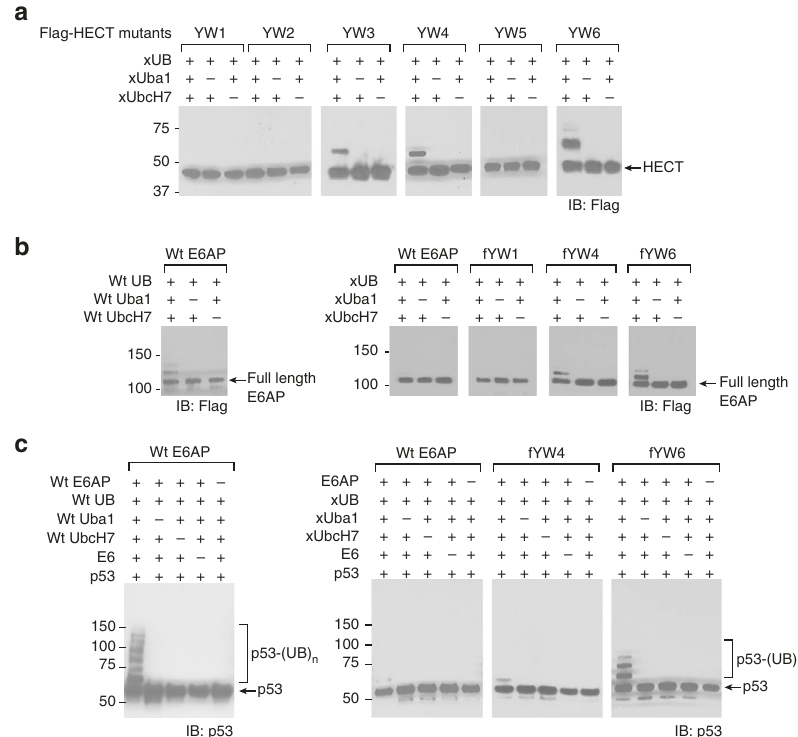
Fig. 3 Activity in xUB transfer by the E6AP mutants identi fi ed from yeast cell selection. a Activity of the HECT mutants YW1 – 6 in auto-ubiquitination by xUB through the xUba1 – xUbcH7 pair. b Activity of the full-length E6AP mutants fYW1, fYW4, and fYW6 in auto-ubiquitination by the xUba1 – xUbcH7 pair (right panel). While wt E6AP can be auto-ubiquitinated by the wt Uba1 – UbcH7 pair (left panel), it cannot be conjugated to xUB by the xUba1 – xUbcH7 pair (right panel). c p53 ubiquitination by wt E6AP and fYW4 and fYW6 in the presence of E6. p53 can be ef fi ciently ubiquitinated by wt UB through the